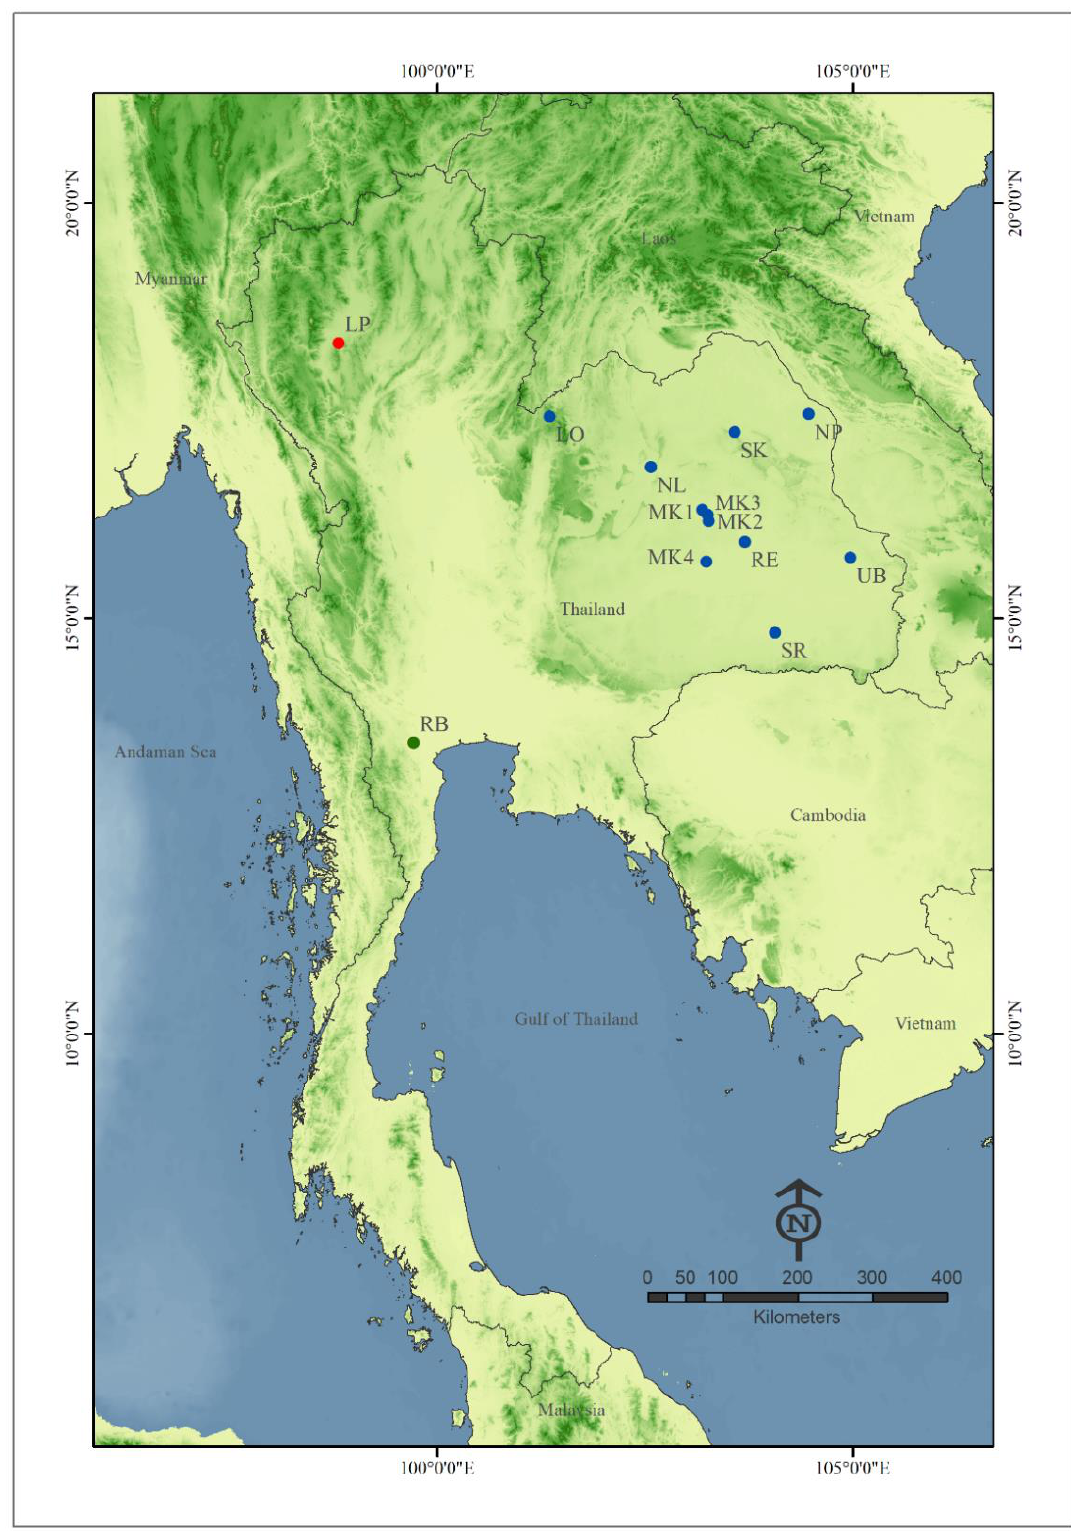
Figure 1. Map of Thailand (modified from http://mitrearth.org (accessed on 1 August 2022)) indicat- ing the 13 sampling locations of Culicoides mahasarakhamense used in this study. Details of sampling locations are included in Table 1. Locality symbols are labeled according to geographic region: red, north; blue, northeast; green,